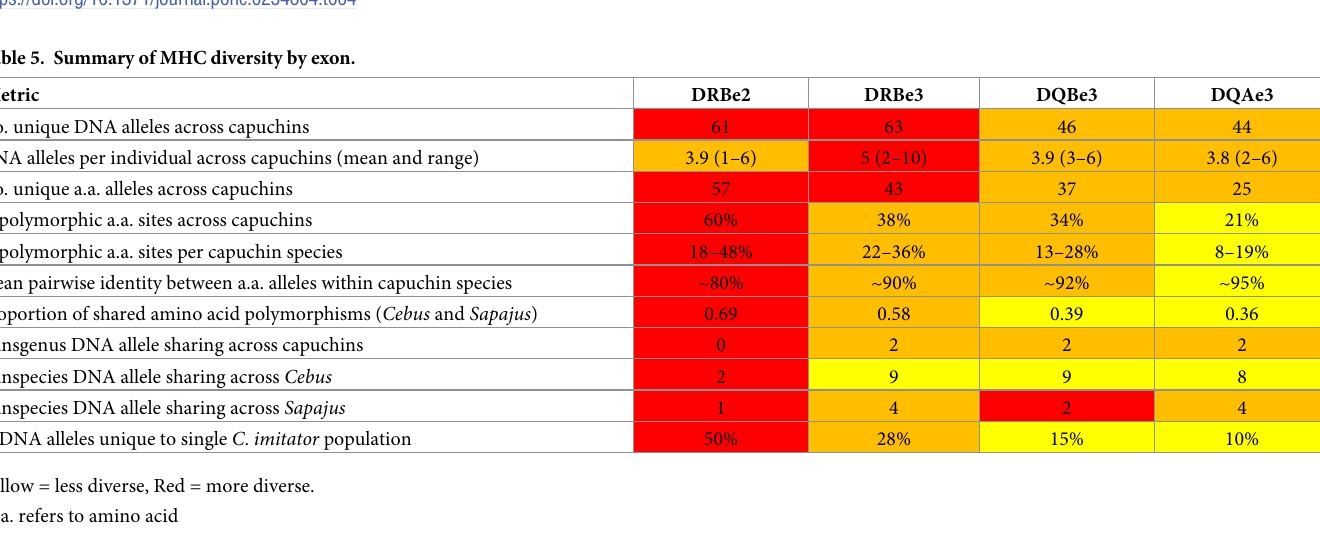
Table 5. Summary of MHC diversity by